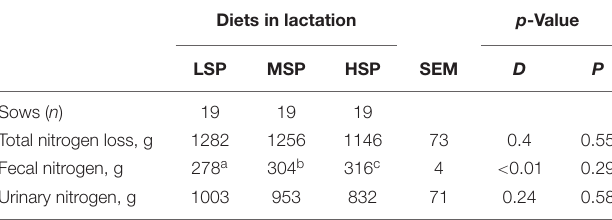
D, diet [LSP/MSP/HSP, where LSP, low level of slow protein diet (8%); MSP, medium level of slow protein diet (12%); HSP, high level of slow protein diet (16%); P, parity class (4/5, where 4 = sows in parity 3 and parity 4; 5 = sows in parity 5)]. a − c LSmeans within a row with different superscripts differ significantly at p <